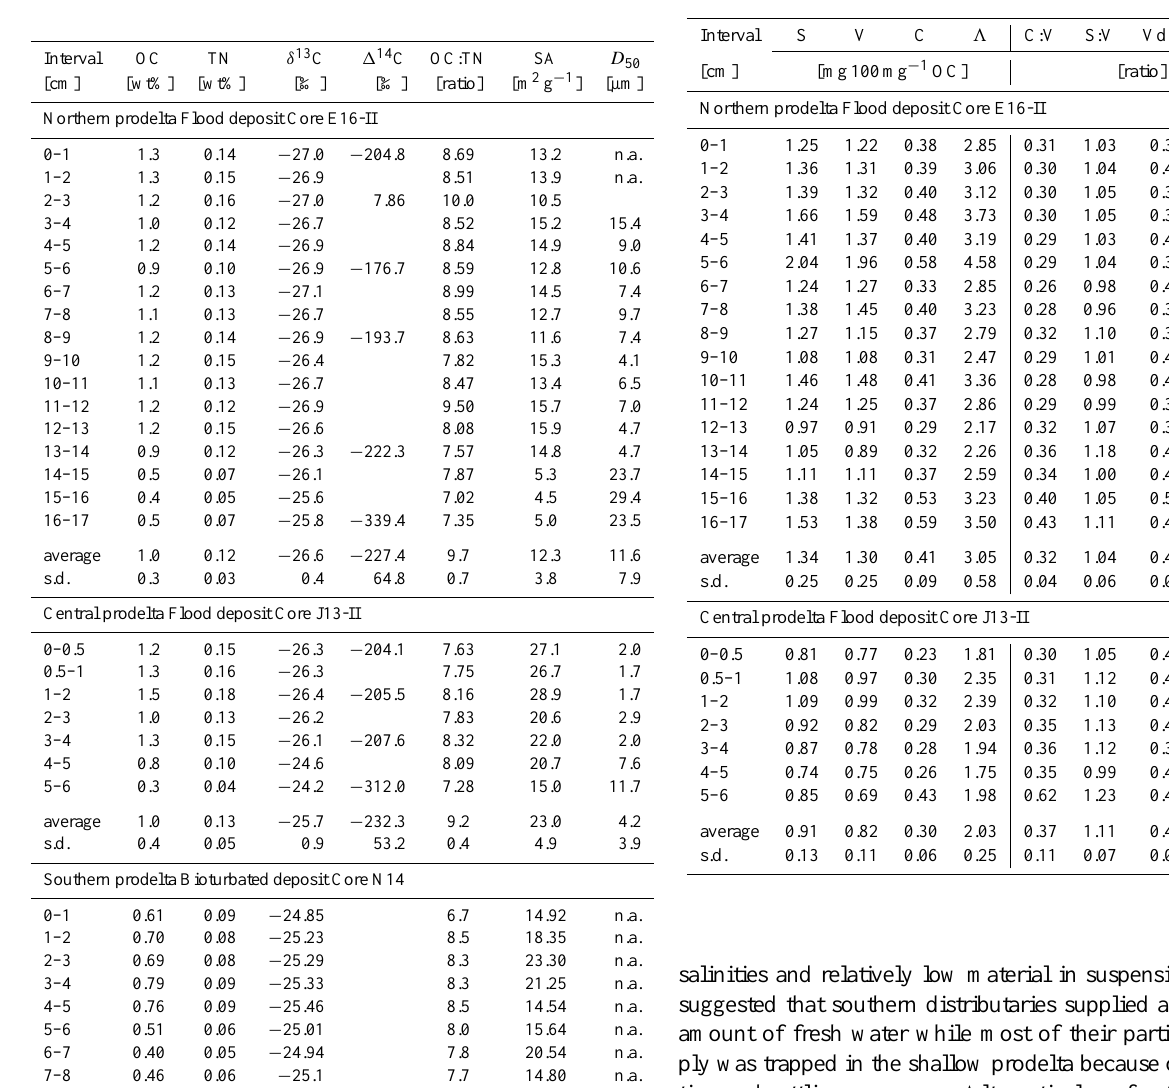
Table 7. Lignin biomarkers for sediment cores collected in the Po prodelta after the May 2009